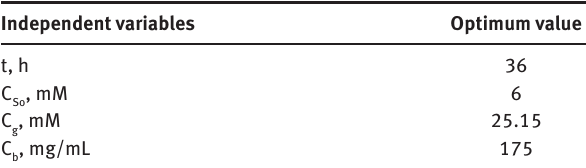
Table 4: Optimum values of independent variables obtained with